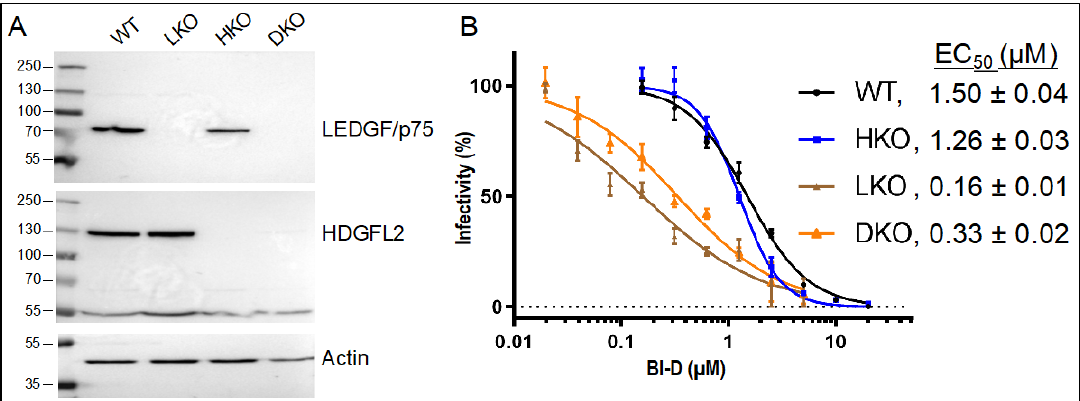
Figure 1. Characterization of LEDGF/p75 and HDGFL2 KO cells and BI-D dose response curves. ( A ) Western immunoblots using anti-LEDGF/p75 and anti-HDGFL2 antibodies; actin was used as a loading control. The analyzed HEK293T cell type is indicated atop the upper blot. WT, wild type; LKO, LEDGF/p75 knockout; HKO, HDGFL2 knockout; DKO, double knockout. Numbers to the left indicate positions of mass markers in kDa. Results are representative of those observed in three independent experiments. ( B ) BI-D dose response curves using the indicated cell types. Calculated EC 50 values are shown (average ± standard deviation for n = 2 independent experiments; data points within each experiment were derived from technical triplicate samples).